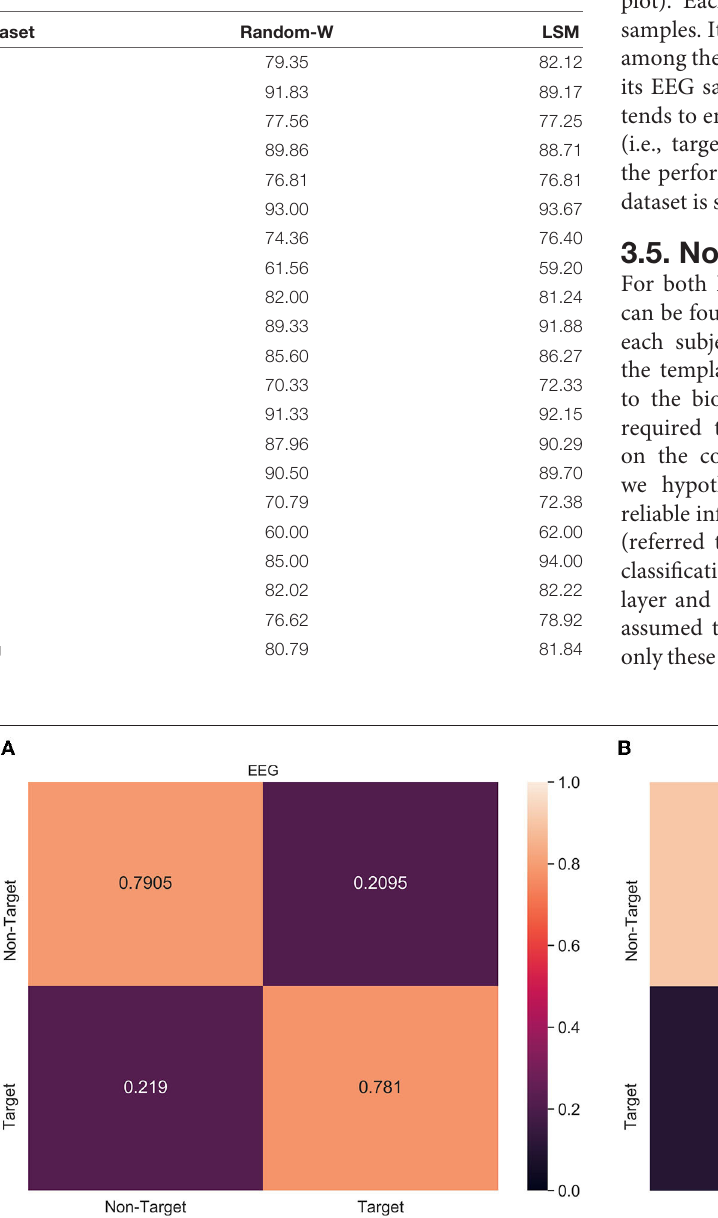
FIGURE 4 | Confusion matrix analysis of (A) EEG and (B) Spike-representation (from LIF) of ERN dataset. Recognition of both Target and Non-Target categories improved for spike-representation compared to EEG signal.